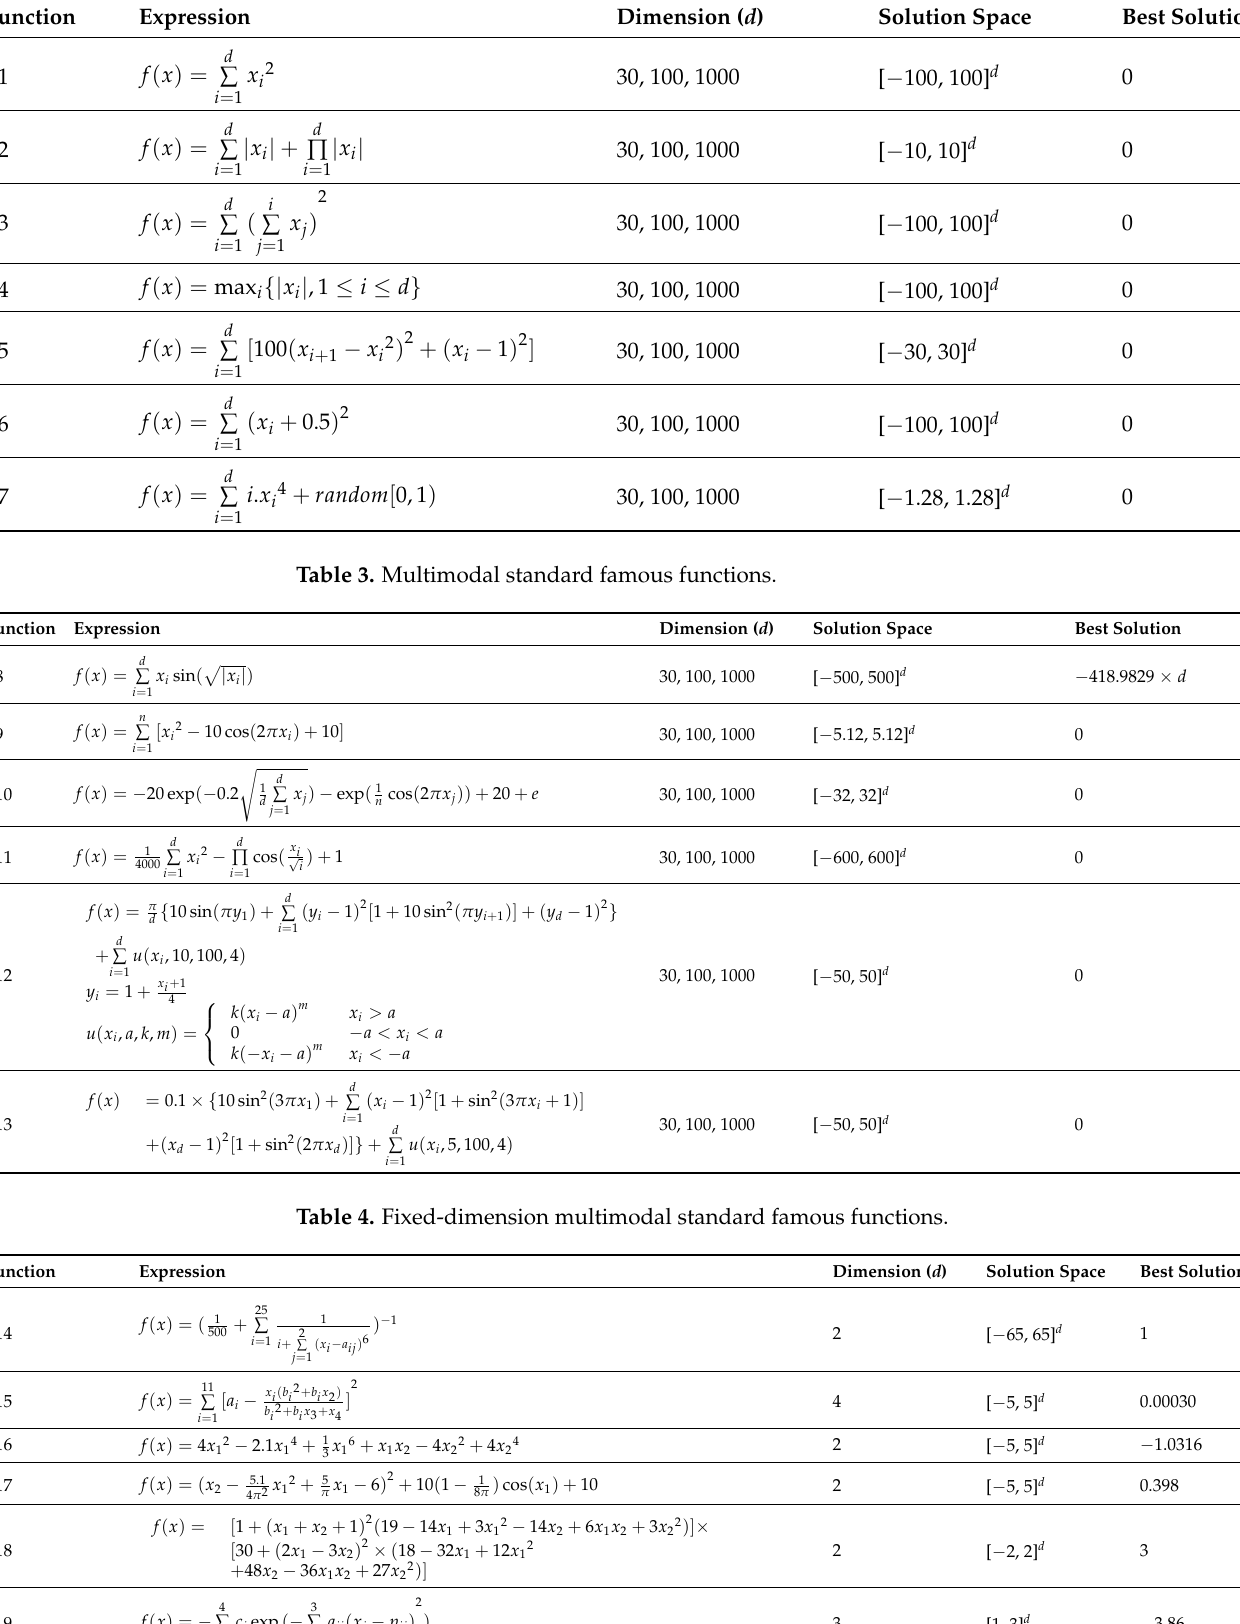
Table 2. Unimodal standard famous functions.